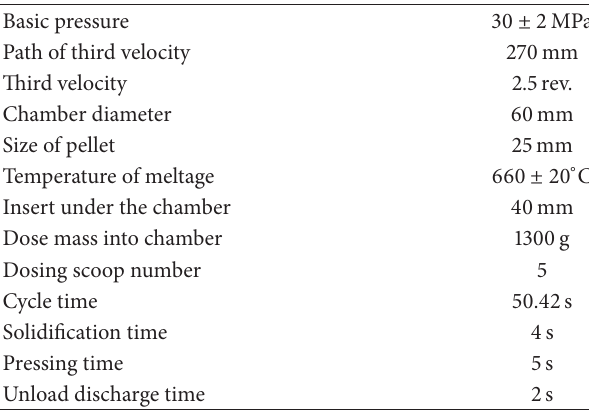
Table 2: Technological order and casting